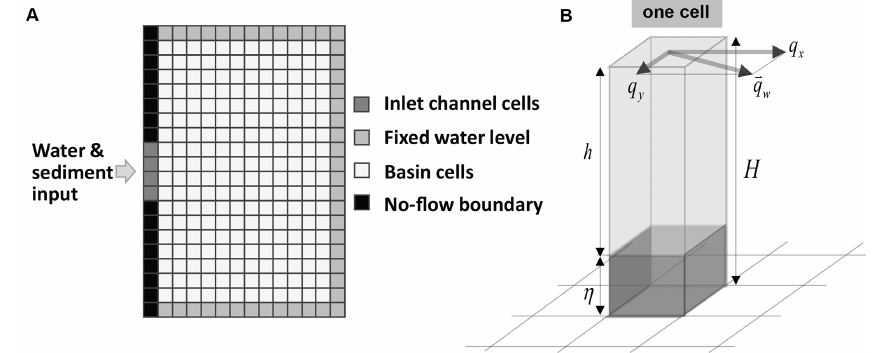
Figure 1. Basic setup of the model. (a) The calculation domain is represented by a lattice of square cells (shown as a diagram). (b) Primary values associated with each cell include flow depth, water surface elevation, bed elevation and flow unit discharge